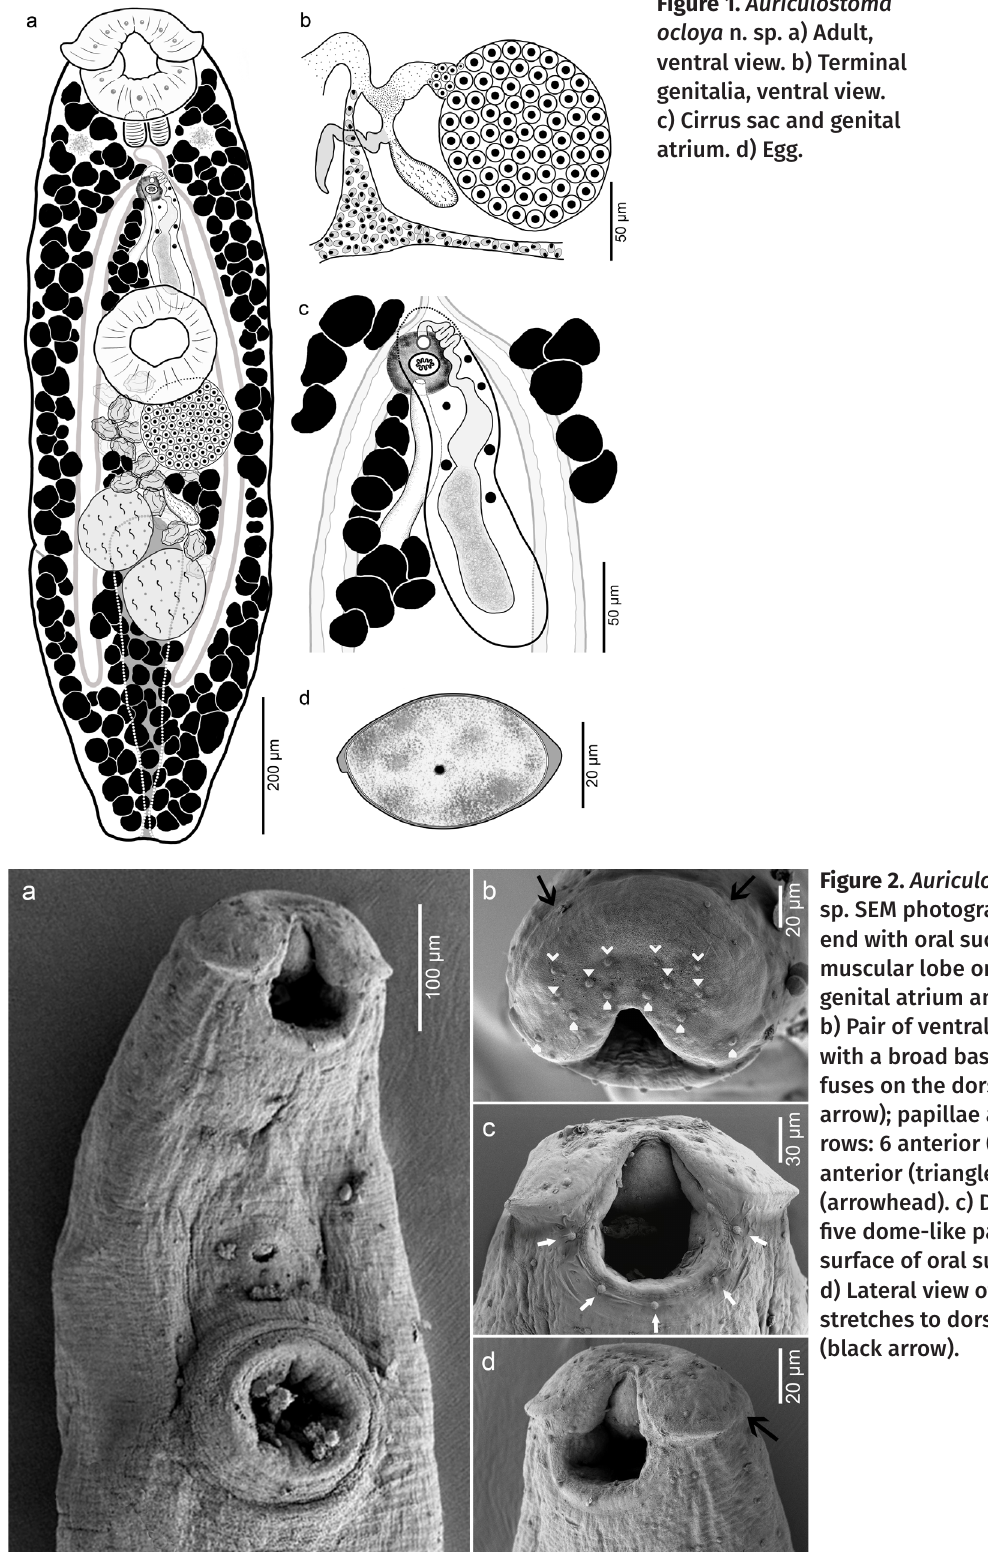
Figure 2. Auriculostoma ocloya